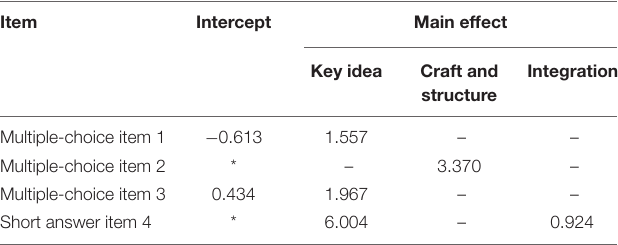
TABLE 2 | Item parameter estimates for the log-linear cognitive diagnostic model for students’ reading skills.